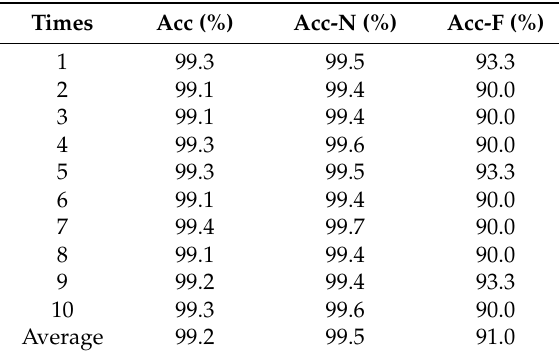
Table 3. The recognition of the